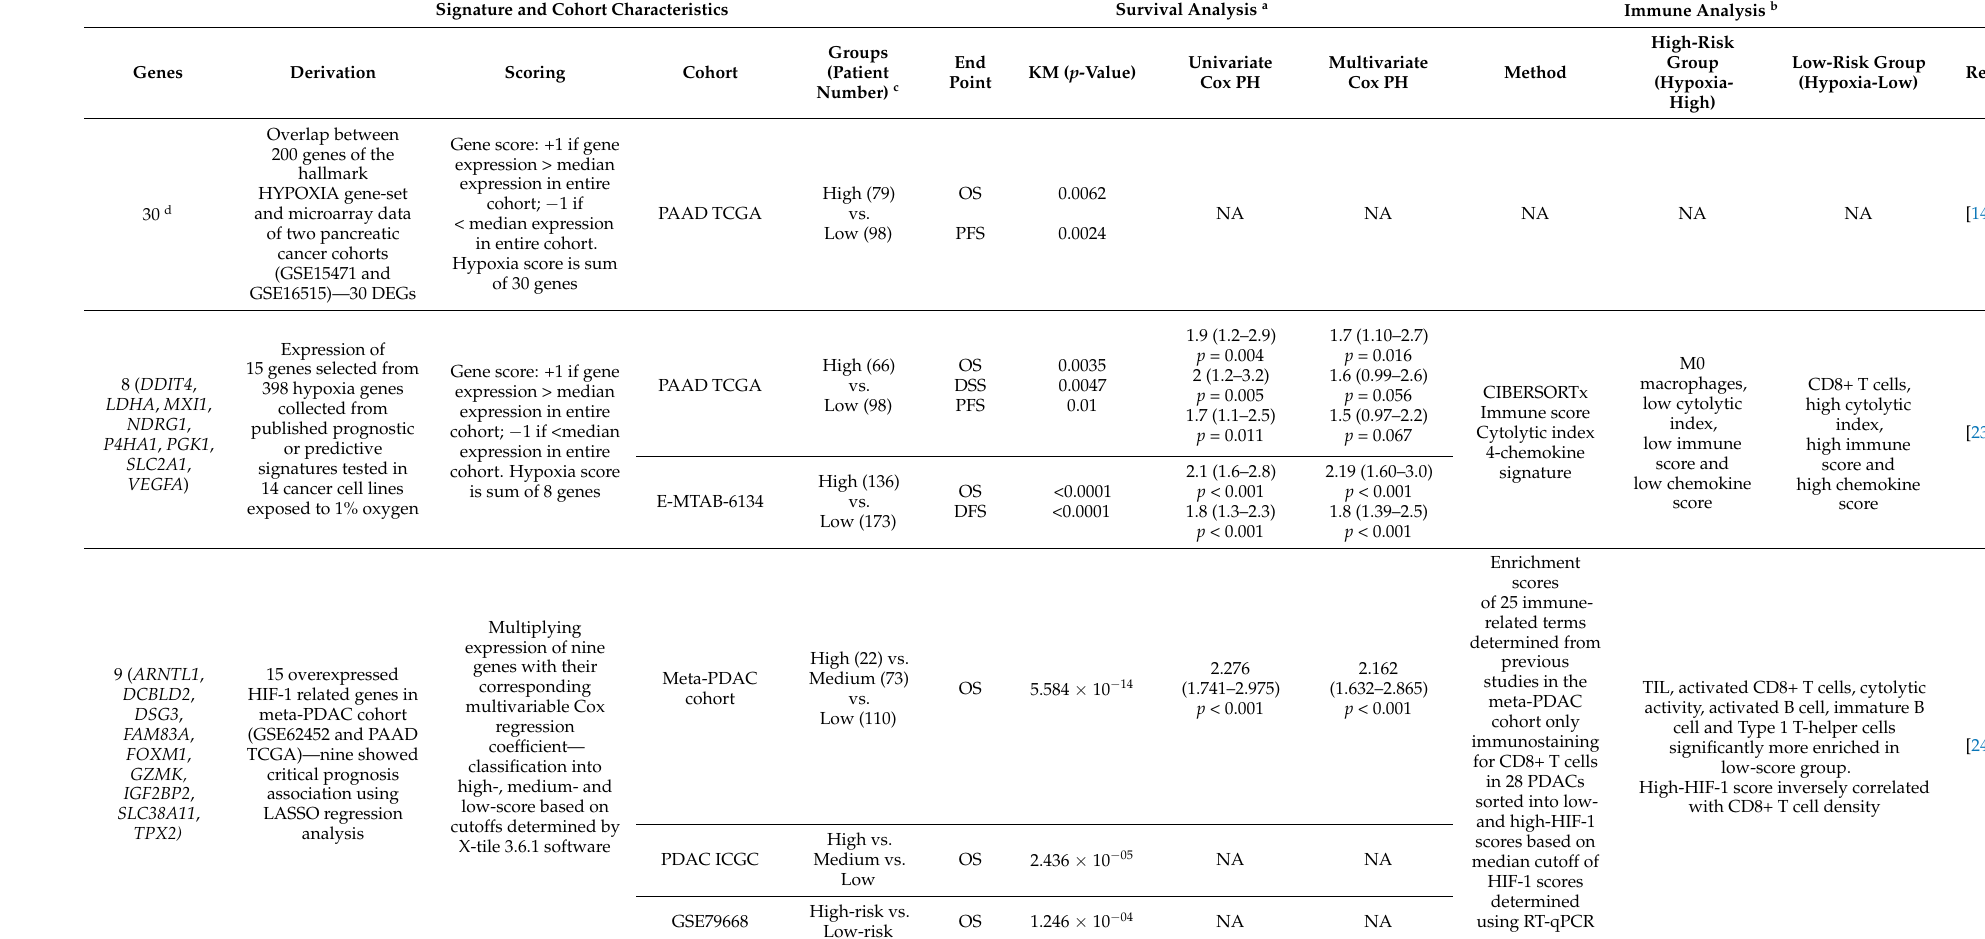
Table 4. Prognostic hypoxia gene signatures in pancreatic